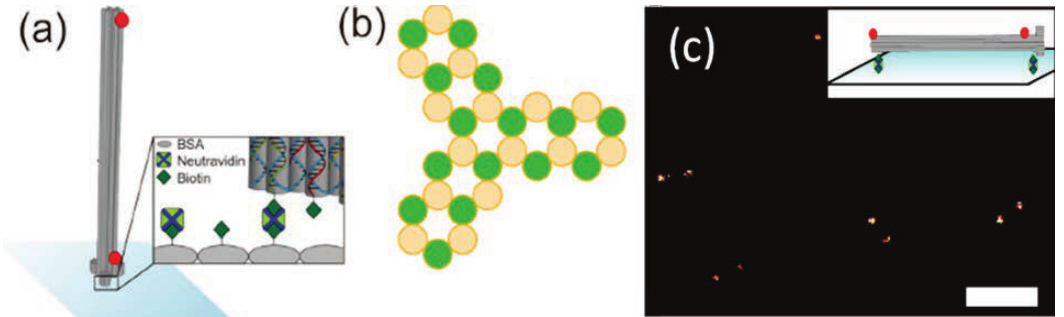
Figure 13. (a) Sketch of the DNA origami nanopillar with Alexa647 dye (shown in red). (b) Cross section of helices for the base of the nanopillar. Biotin-labeled helices are shown in green. Reprinted with permission from [ 62]. Copyright 2013 American Chemical Society